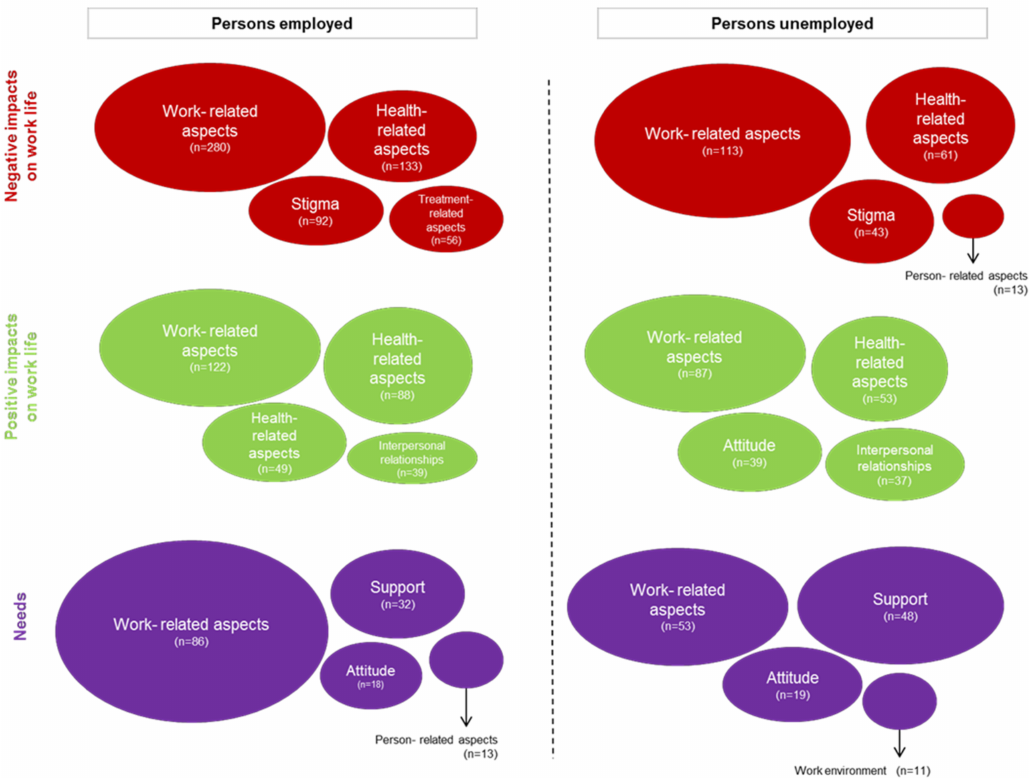
Figure 4. Themes stratified by the occupational status (employed and unemployed persons). The size of the circles is displayed according to the relative frequencies of the themes within the employed and unemployed persons,